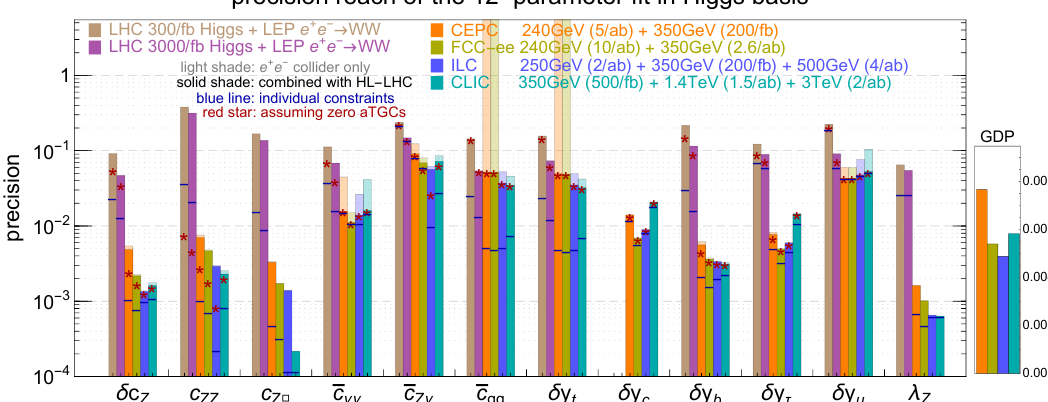
Figure 7 . One-sigma precision reach of future lepton colliders on our e(cid:11)ective-(cid:12)eld-theory param- eters. All results but the light-shaded columns include the 14 TeV LHC (with 3000 fb (cid:0) 1 ) and LEP measurements. LHC constraints also include measurements carried out at 8 TeV. Note that, without run above the t (cid:22) th threshold, circular colliders alone do not constrain the (cid:22) c gg and (cid:14)y t e(cid:11)ective-(cid:12)eld- theory parameter individually. The combination with LHC measurements however resolves this (cid:13)at direction. The horizontal blue lines on each column correspond to the constraints obtained when one single parameter is kept at the time, assuming all others vanish. The red stars correspond to the constraints assuming vanishing aTGCs. The GDPs of future lepton colliders are shown on the right panel. See main text for comparisons with the LHC